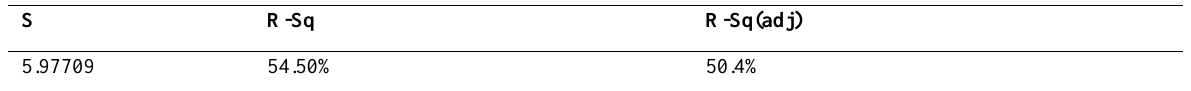
Table 3: Coefficient of Determination